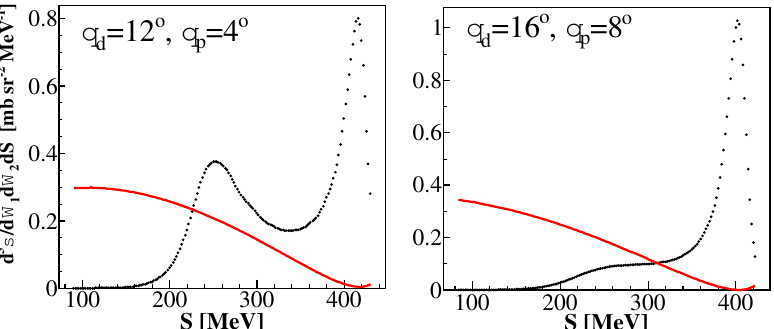
Figure 5: (Color online) Differential cross section for the angular configuration spec- ified in the figures. The black points refer to the SSA calculations based on the CD Bonn + ∆ potential in the 4-term version. The solid red line present the dependence of the spectator neutron energy (E ) on the S n